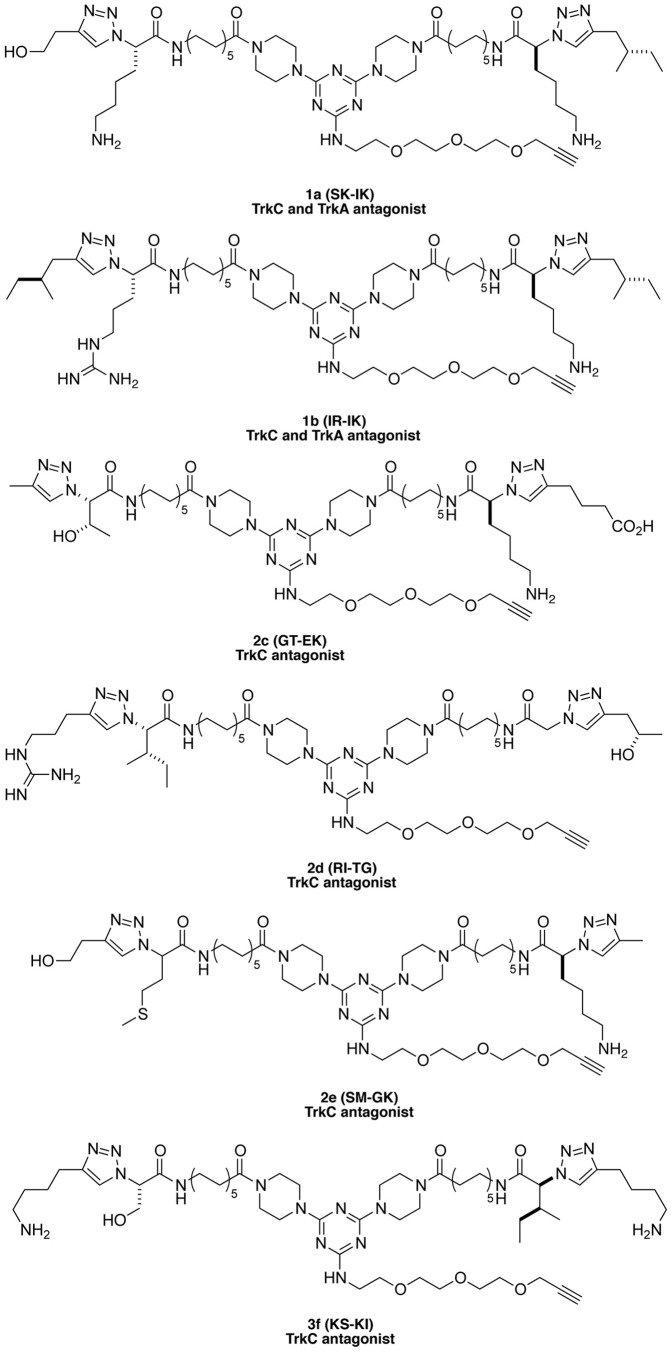
Structures of antagonists for TrkC or TrkA.